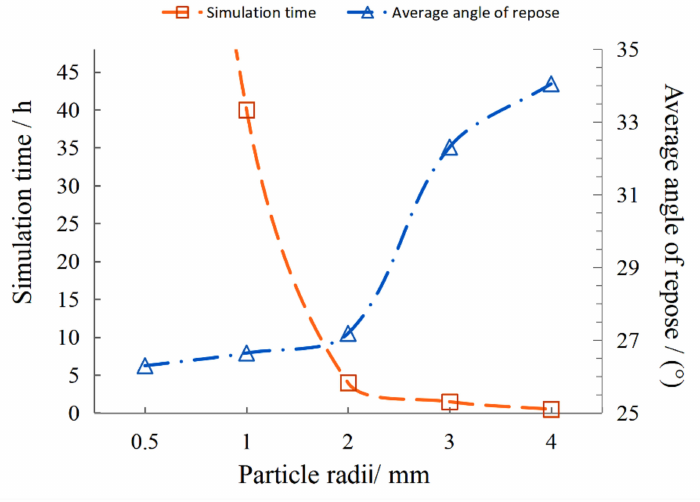
Figure 10. Relationship between particle radii and the sugarcane leaf simulation efficiency, angle of